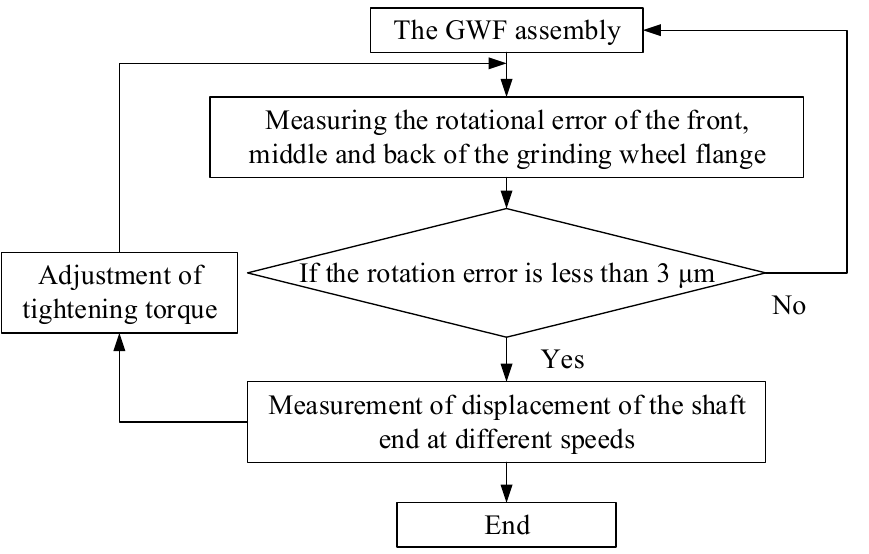
Figure 15. The test flow of spindle vibration.